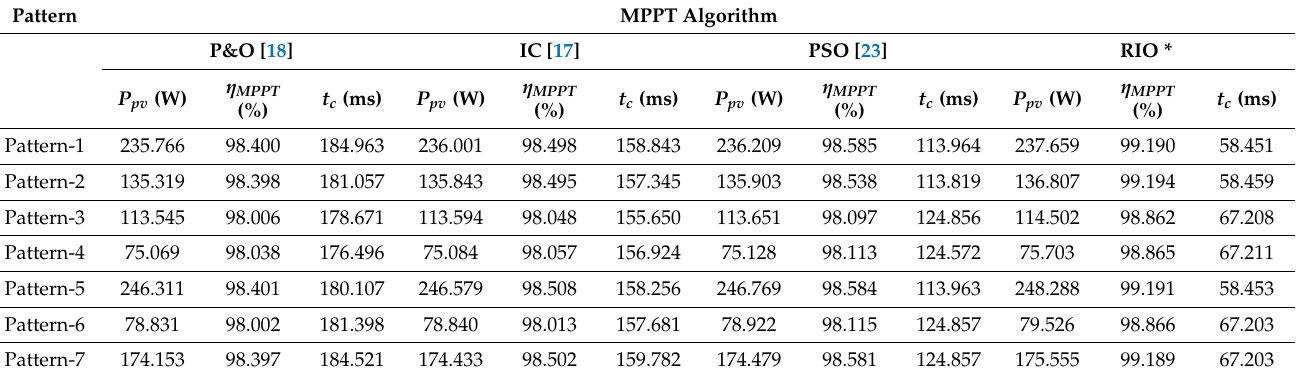
Table 8. Comparative performance of different MPPT